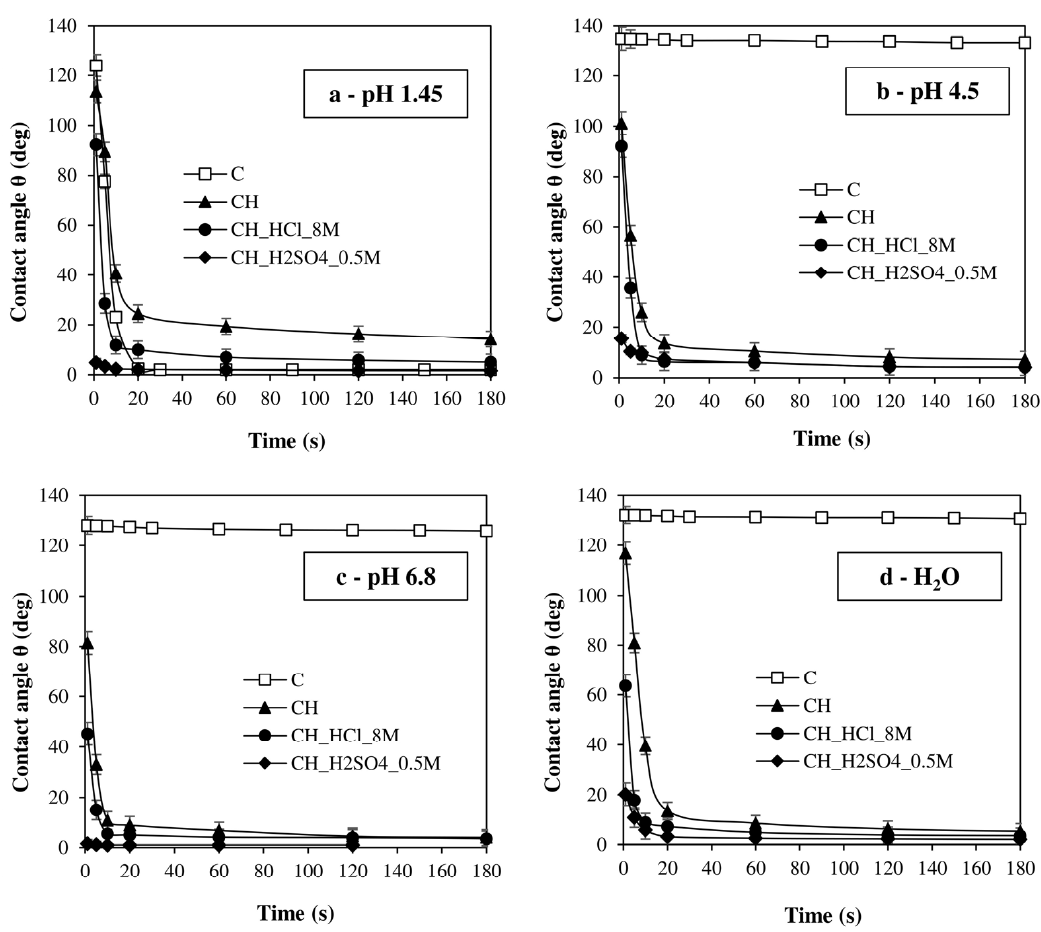
Figure 12. Contact angle (deg) measured on C alone and CH, CH_HCl_8M, and CH_H 2 SO 4 _0.5M using different wetting fluids at pH 1.45 ( a ) (USP monograph), in which the drug is more soluble; at pH 4.5 ( b ), simulating gastric fed conditions; pH 6.8 ( c ), simulating intestinal environment and deionized water ( d ).